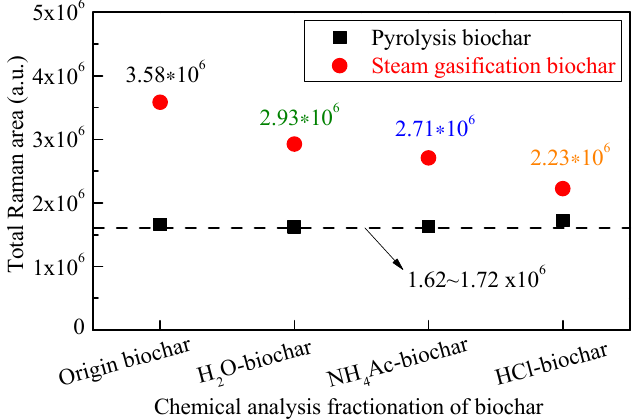
Figure 7. Total Raman area of biochar during steam gasification.